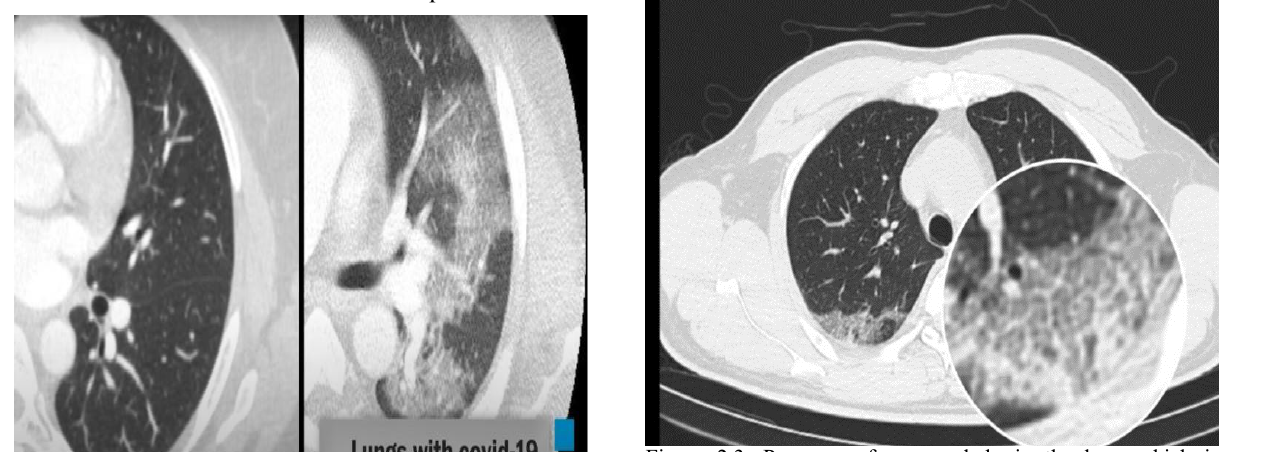
Figure 2.3: Presence of reverse halo in the lung which is enlarged for convenience [4]